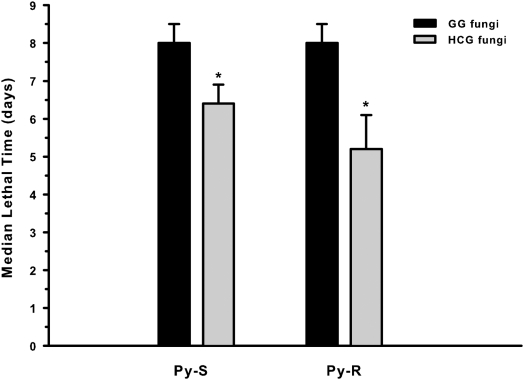
Median lethal time of both pyrethroid-susceptible (Py-S) and pyrethroid-resistant (Py-R) T. infestans treated with B. bassiana grown on two different carbon sources, under laboratory conditions.Fifth-instar nymphs were immersed for 6 seconds in a fungal suspension (2×108 con/ml). Values are means±SD. Significant differences (P<0.05) between glucose-grown (GG) and hydrocarbon-grown (HCG) fungi are shown with an asterisk.